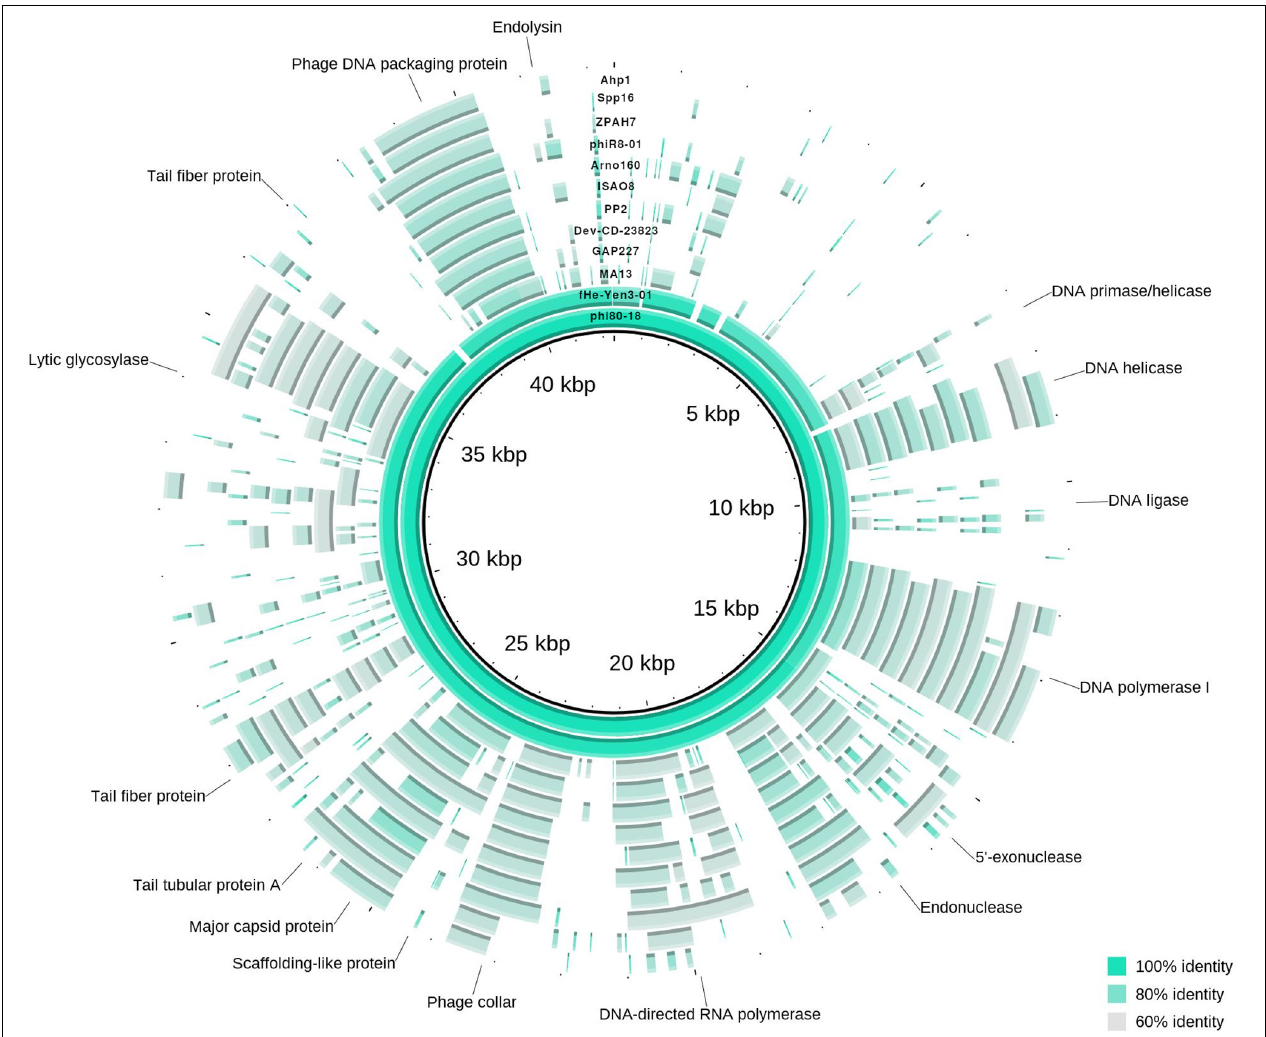
FIGURE 4 | Genome map of φ 80-18 and alignment to closely related bacteriophages according to phylogenetic analysis. The circular map represents the genome alignment of phages closely related to φ 80-18, forming an unified cluster in phylogenetic tree (marked in Figure 2 ). Several predicted genes indicated with putative product names, the others remain as hypothetical proteins. Fragments, showing more than 60% identity with the φ 80-18 genome sequence, are colored. The closest related phage, fHe-Yen03-1, scores over 92% of sequence identity and differ from φ 80-18 only in minor traits (described in text). The other phages all more distantly related with below 75.5% identity. The most conserved genomic regions between the phages contain genes encoding DNA-processing proteins such as helicase, polymerases or DNA packaging protein.